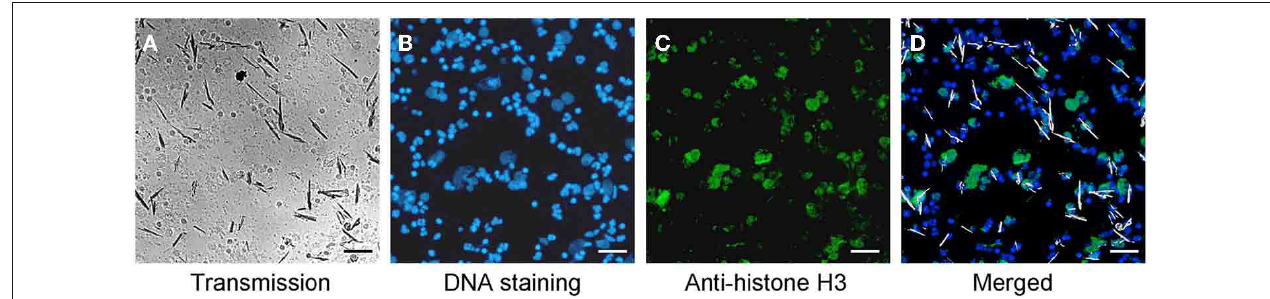
FIGURE 2 | MSUinducedNETscontainhistonH3. (A–D) Wholebloodcellswere incubated with MSUcrystals. Cytospins were prepared and stained for nuclear and extranuclear DNA (B) and histon H3 (C) . The merged picture (D) shows the